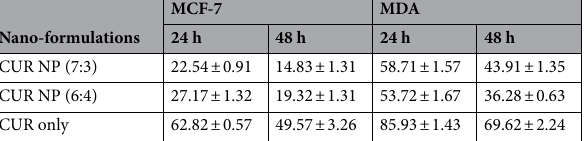
Nano-formulations